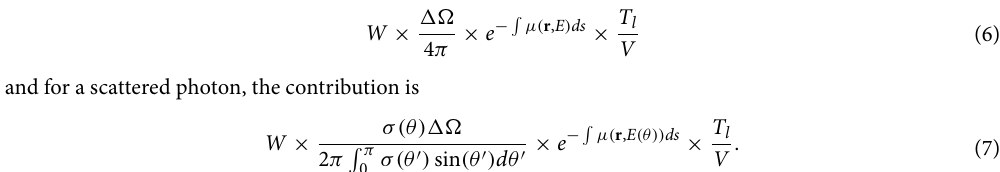
The response to each fine pixel whose center point is inside the pin is calculated in the following way. A pho- ton ( r 0 , � 0 , E 0 , W 0 ) is created, with the initial position r 0 uniformly sampled inside the pixel, the initial moving direction (cid:31) 0 uniformly sampled in 4 π space, the initial energy E 0 sampled from the source energy spectrum, and